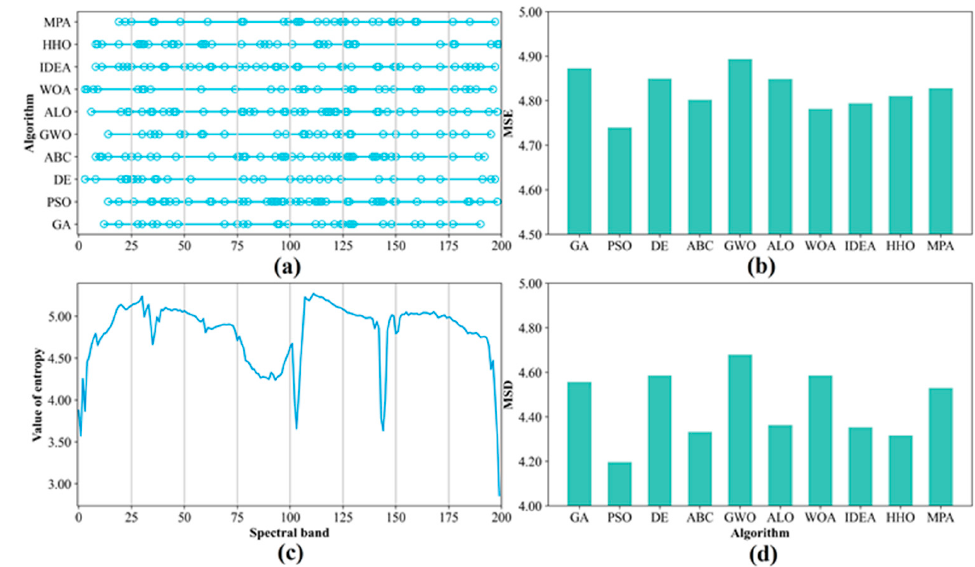
Figure 7. Analysis of the selected bands on the Indian Pines: ( a ) selected bands from the methods, ( b ) MSE value, ( c ) entropy value of each band of the dataset, and ( d ) MSD value.